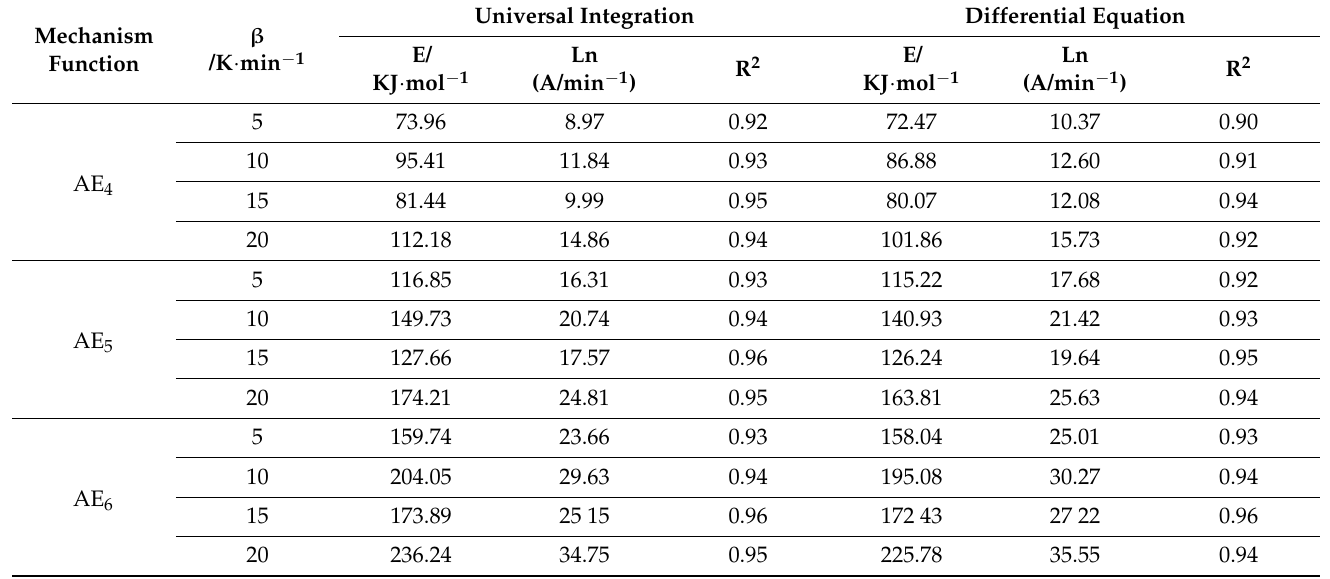
Table 5. Kinetic parameters of universal integral equations and differential equations based on